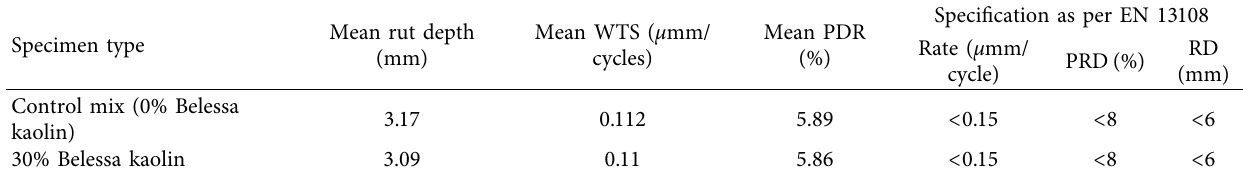
Table 12: Summary of wheel truck test result at optimum Belessa kaolin and control